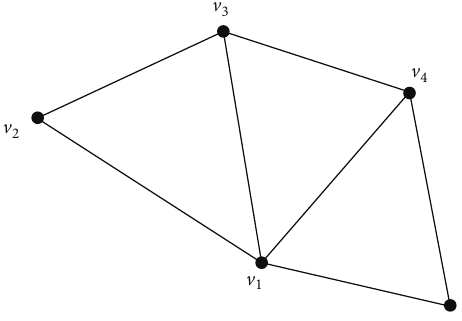
Figure 1: Graph with 5 vertices and 7